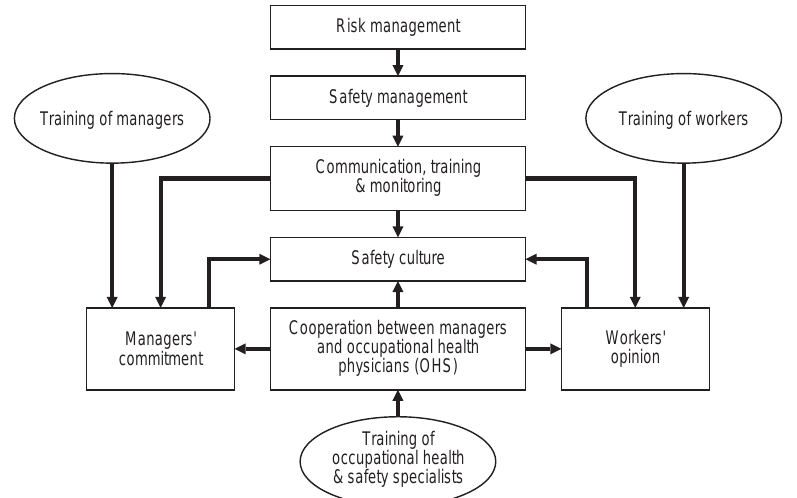
Fig. 4. The infl uence of different parties on OH&S at